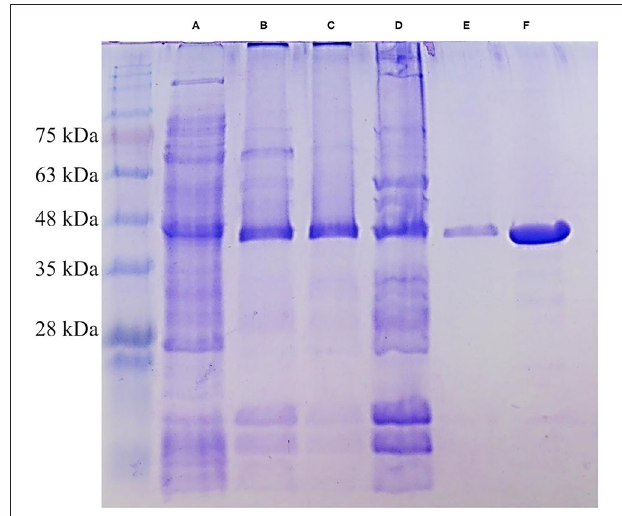
FIGURE 2 | SDS-PAGE of different purification steps of Xyl43Nc. Crude protein extract (A) , affinity chromatography fraction 1 (B) , affinity chromatography fraction 2 (C) , pool of both fractions (D) , size exclusion chromatography (E) and concentrated size exclusion chromatography (F) . The strong band of Xyl43Nc between 35 and 48 kDa is visible in all samples. Marker: Bluestar Protein Ladder 10–180 kDa (Nippon